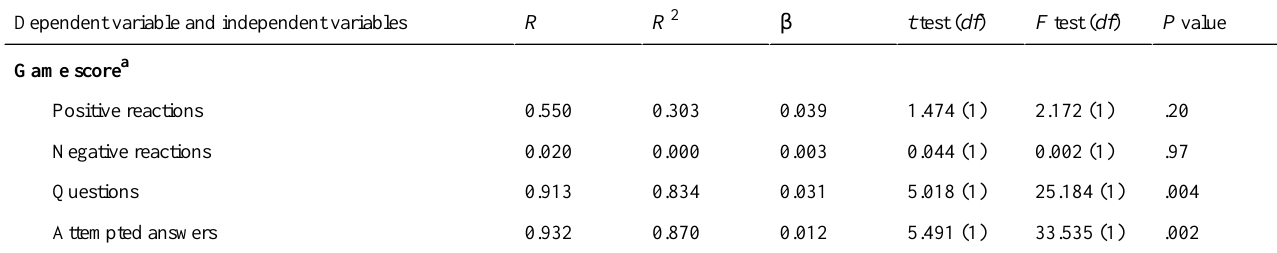
Table 3. Simple linear regression analysis results of participants’communication acts related to the game